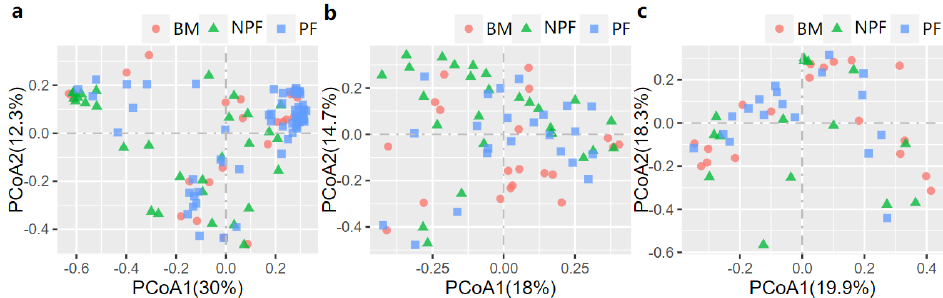
Figure 2. Bray − Curtis distances displayed by PCoA plots showing the profile of gut microbiota at Week 1 ( a ), Week 6 ( b ) and Week 12 ( c ). PCoA, principal coordinate analysis; BF, breastmilk feeding; FF, formula feeding.